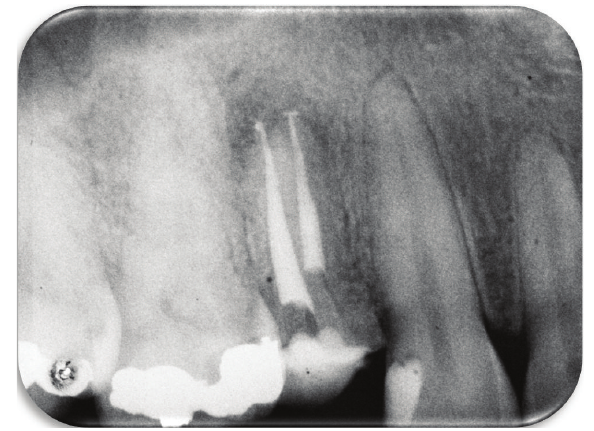
Figure 4: Photograph of the set hypodermic needle-fragment removed from the root canal.